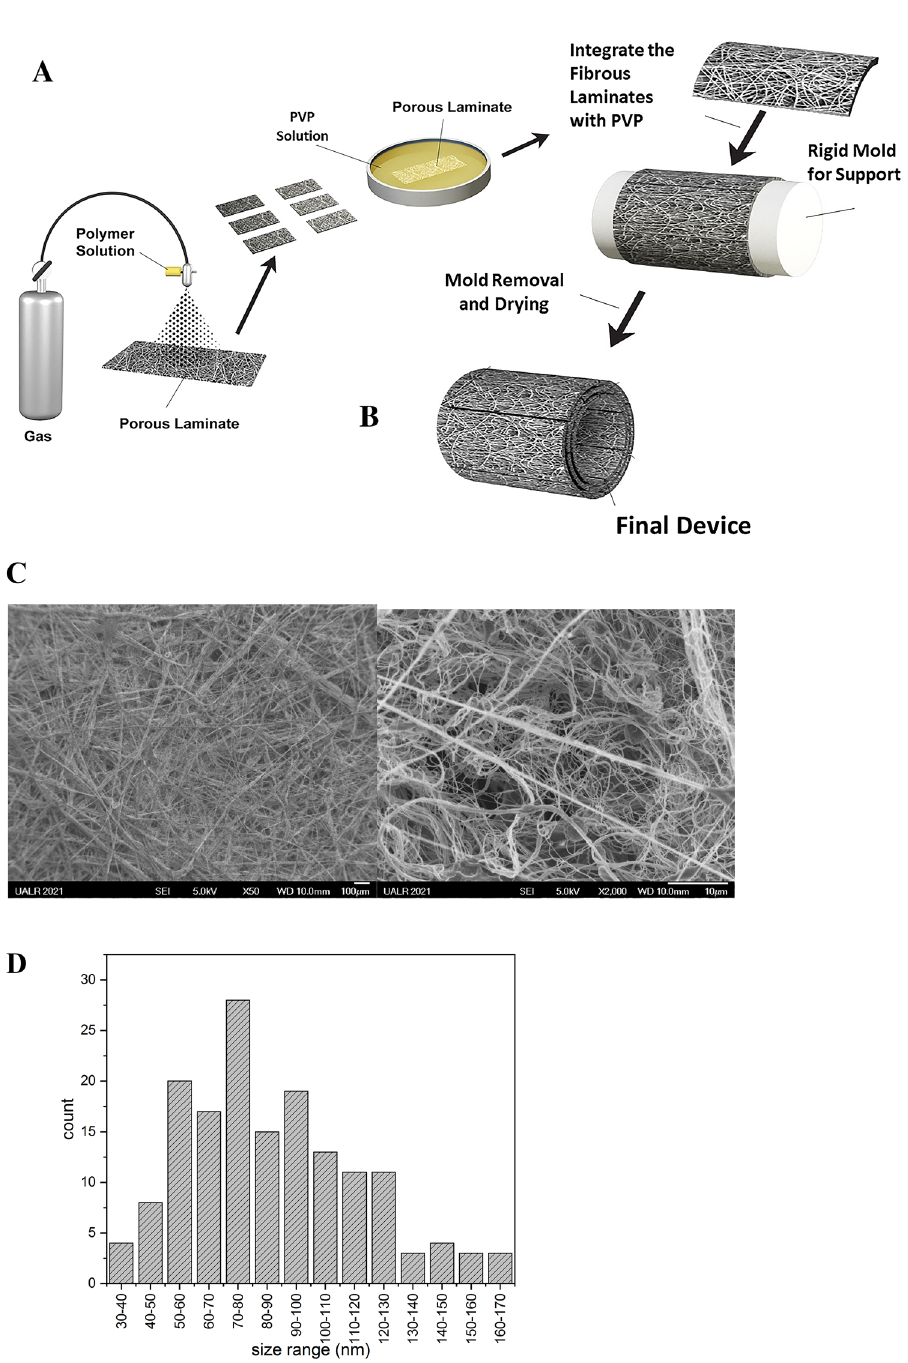
Figure 1. Device fabrication steps: ( A ) the porous polymer laminates were saturated with adhesive solution then assembled over support mold; ( B ) the support mold was removed and the device left to dry for 48 h; ( C ) low (left) and high (right) magnification SEM images of the polymer films used for the formation of the porous laminates; ( D ) diameter size histogram for the as-sprayed fibers, as measured with ImageJ software with a total of n = 159 entry